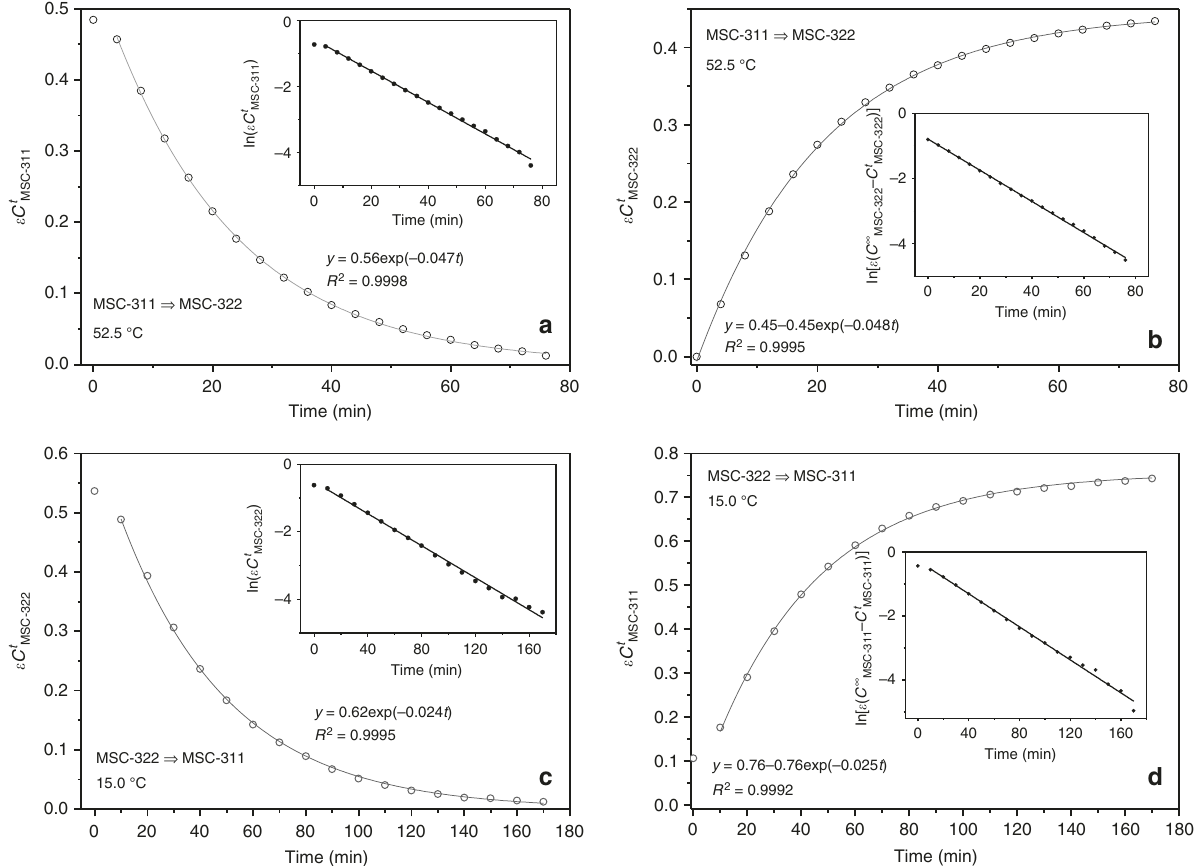
Fig. 4 Kinetic study of the transformations at 52.5 and at 15.0 °C. The time-dependent concentrations (open circles) of the reactants ( a , c ) and products ( b , d ) for the MSC-311 to MSC-322 transformation at 52.5 °C ( a , b ) and the MSC-322 to MSC-311 transformation at 15.0 °C ( c , d ). Each of the two dispersions was prepared from one reaction mixture (~20 mg from the same approach used for Figs. 1 and 2) in toluene (3 mL). The rate constants obtained are 0.047 min − 1 ( a ) and 0.024 min − 1 ( c ), which match well those of 0.048 min − 1 ( b ) and 0.025 min − 1 ( d ), vs. t according to Eq. (1) (solid curve) provides a rate constant, k 322 , – 1 (Fig. 4c). Equation (1) can be converted into Eqs. (2) of 0.024 min and (3), with c being the constant ln C 0 λ . As shown in the insets of (cid:1) (cid:3) Fig. 4, ln C t λ vs. t (solid circles) shows a nearly linear relationship as fi tted by Eq. (2) (solid straight lines). This linear relationship could not be veri fi ed when the reactant concentration was low, due to the presence of relatively large measurement uncertainty in this range, as illustrated by Supplementary Fig. 20.